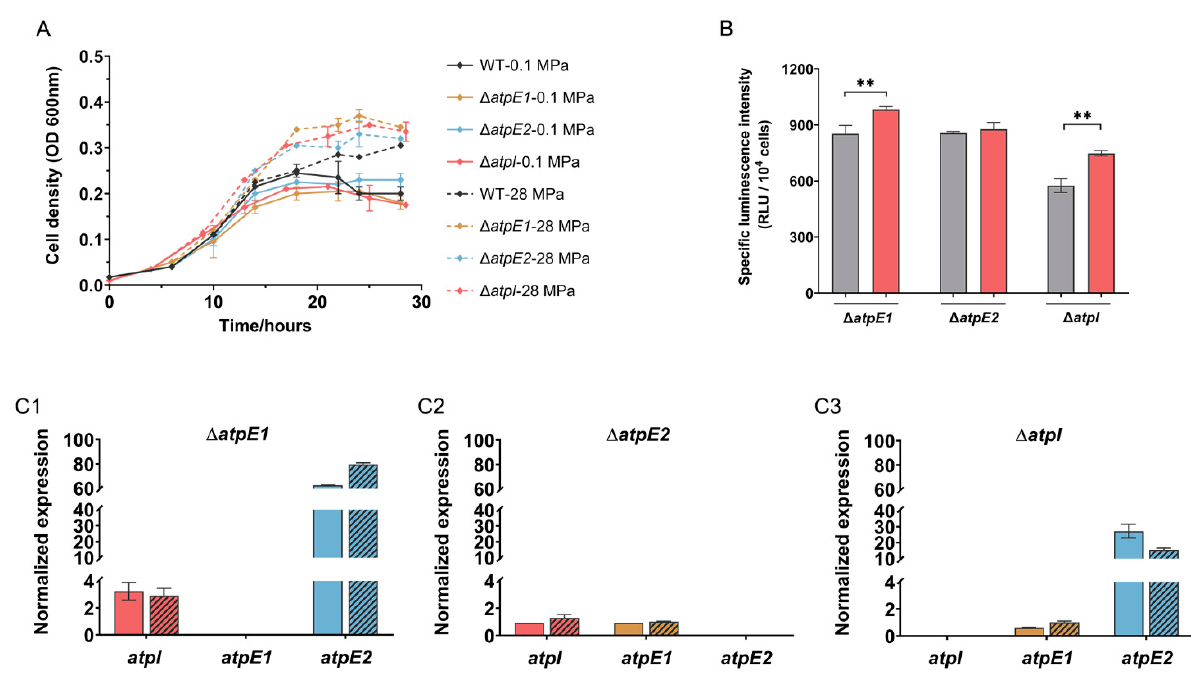
Figure 3. The growth curves, intracellular ATP level and expression of ATPase in ∆ atpE 1, ∆ atpE 2 and ∆ atpI mutants. Panel ( A ), growth curves of wild-type and mutant strains at different pressures. Panel ( B ), specific intracellular ATP level in different mutants. The grey and red bars represent cultures at 0.1 MPa and 28 MPa, respectively. Panel ( C1 – C3 ), expression of atpI , atpE 1 and atpE 2 in the mutants relative to the wild-type strain. A value of 1 means no change from wild-type, whereas 100 mean a 100-fold increase in expression relative to wild type. The colored bars represent relative expression at 0.1 MPa, and colored bars with shadows represent relative expression at 28 MPa. Panel C1, C2 and C3 show the mutant of ∆ atpE 1, ∆ atpE 2 and ∆ atpI , respectively. The statistical analysis of comparisons between two groups was performed using an unpaired-sample t -test: **, p < 0.01.